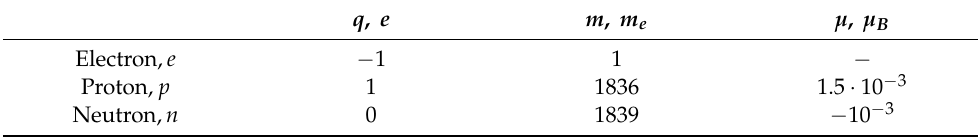
Table A2. The realtion between elctron, proton and